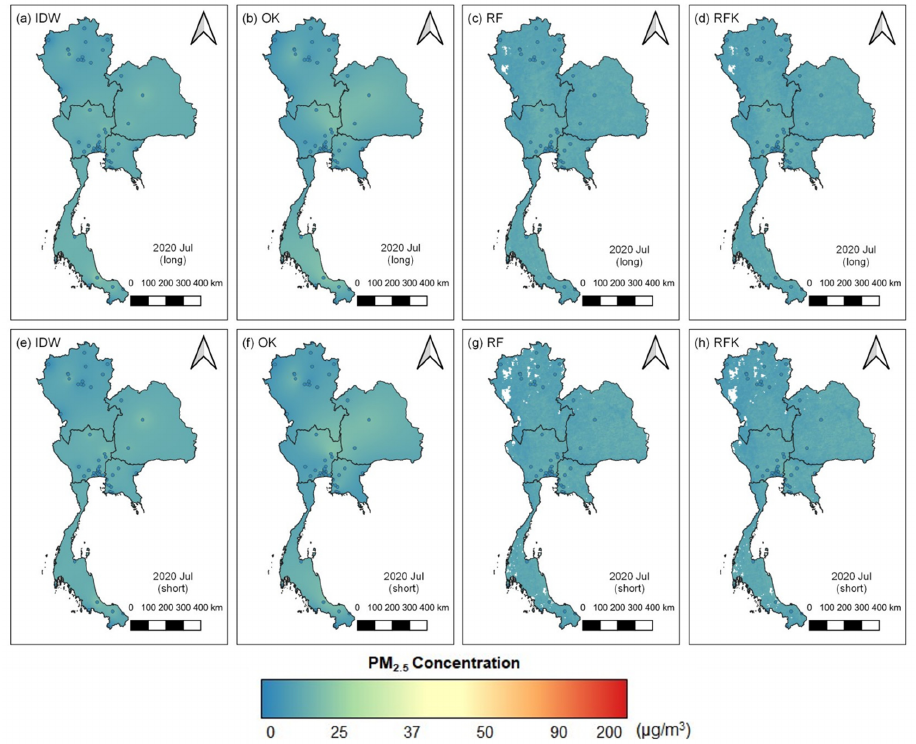
Figure 6. Interpolated PM 2.5 concentrations from different spatial interpolation methods ( a – d ) from 1 to 30 July and ( e – h ) from 9 to 19 July.